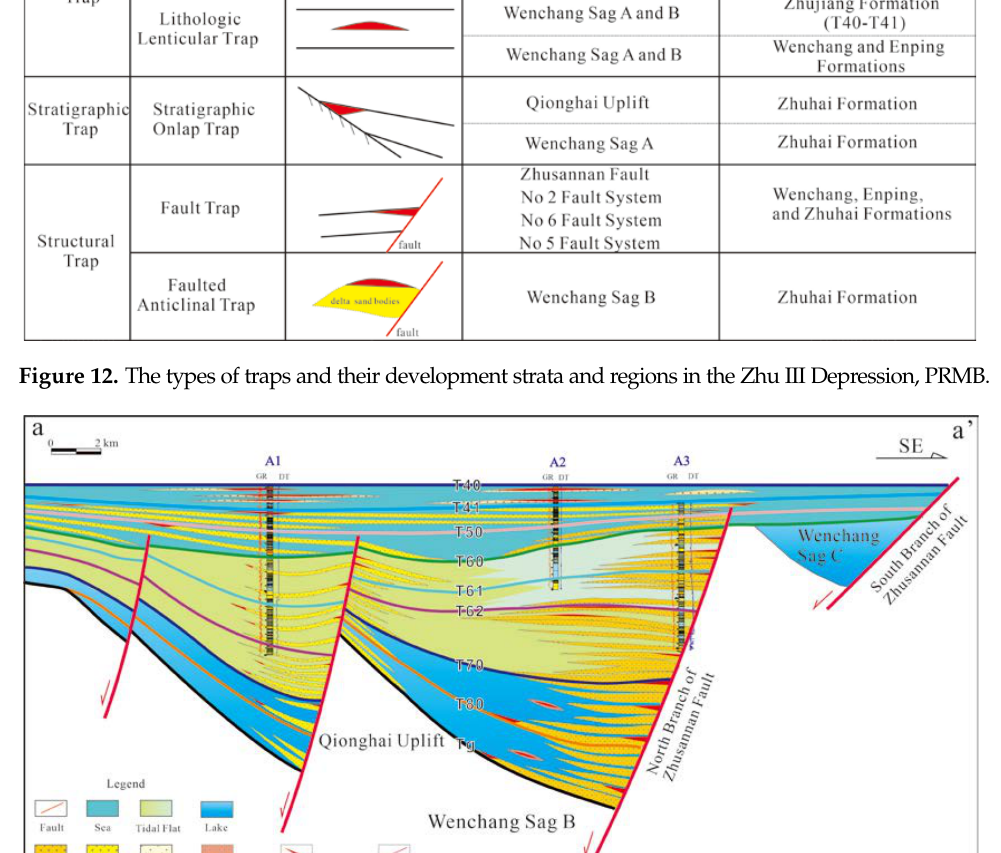
Figure 13. The type and distribution of oil and gas reservoirs across the representative section in the Zhu III Depression, PRMB. The location of section aa’ is shown in Figure 1.